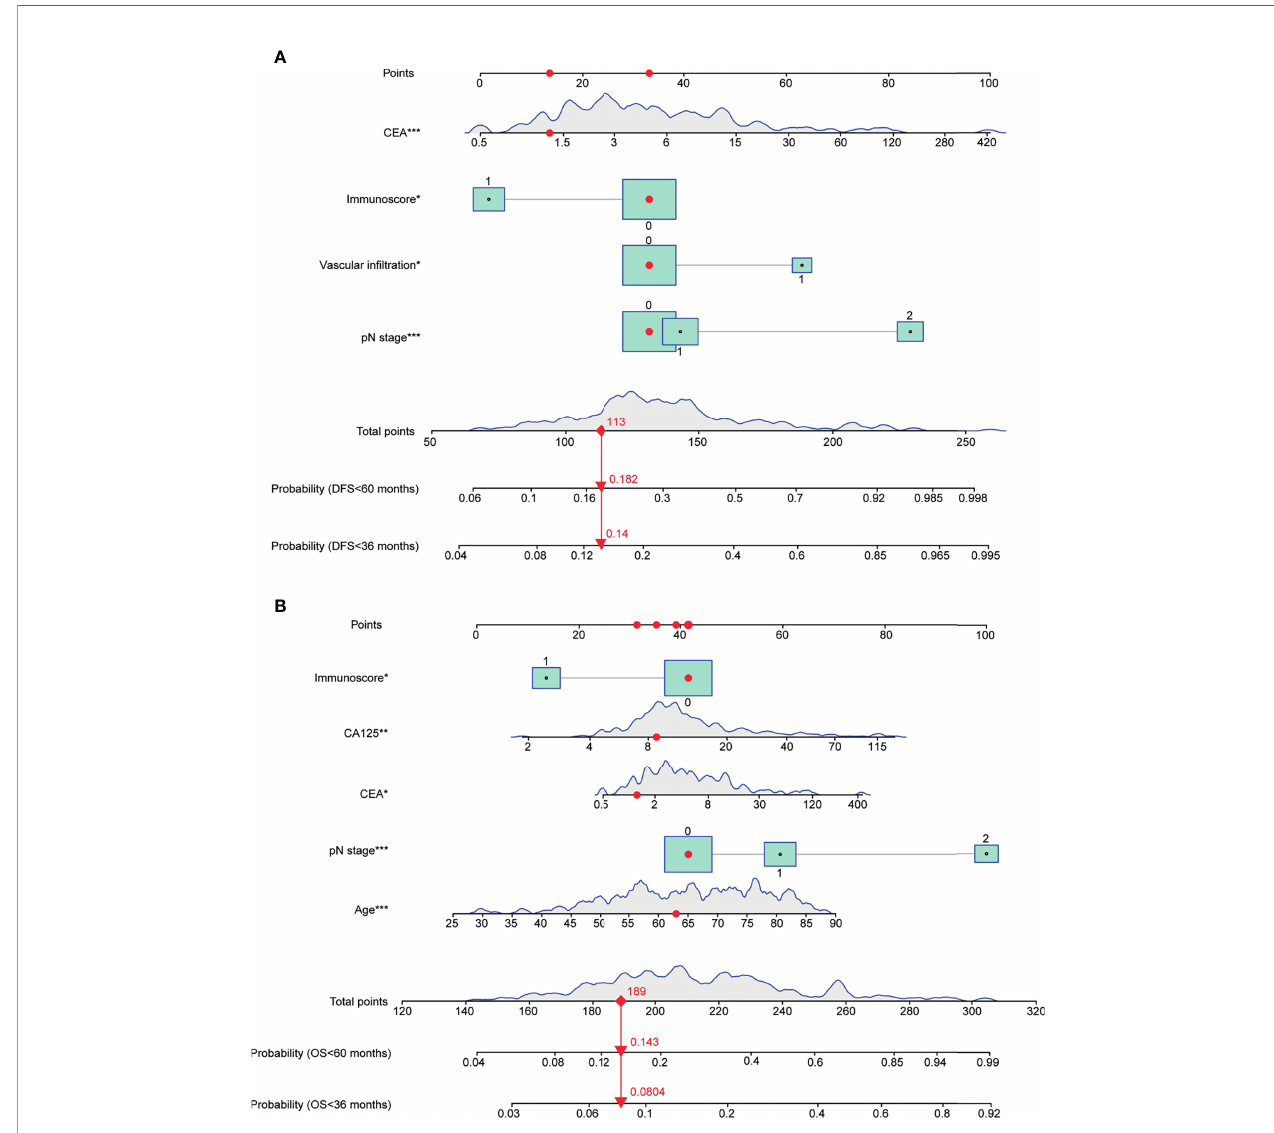
FIGURE 2 | Nomograms for predicting the 3- and 5-year DFS/OS probabilities based on multivariable Cox models. (A) Nomogram for DFS prediction. (B) Nomogram for OS prediction. Continuous or category variables were shown by peaks or rectangles , respectively. The distribution of the peak represents the distribution of sample size, and the size of the rectangles represents the sample size within each category. The nomograms assign points to each variable, and the 3- and 5-year DFS/OS probabilities were predicted by the total points of all variables. The red points and arrows give an example for DFS and OS prediction. OS, overall survival; DFS, disease-free survival (*P < 0.05, **P < 0.01, ***P <